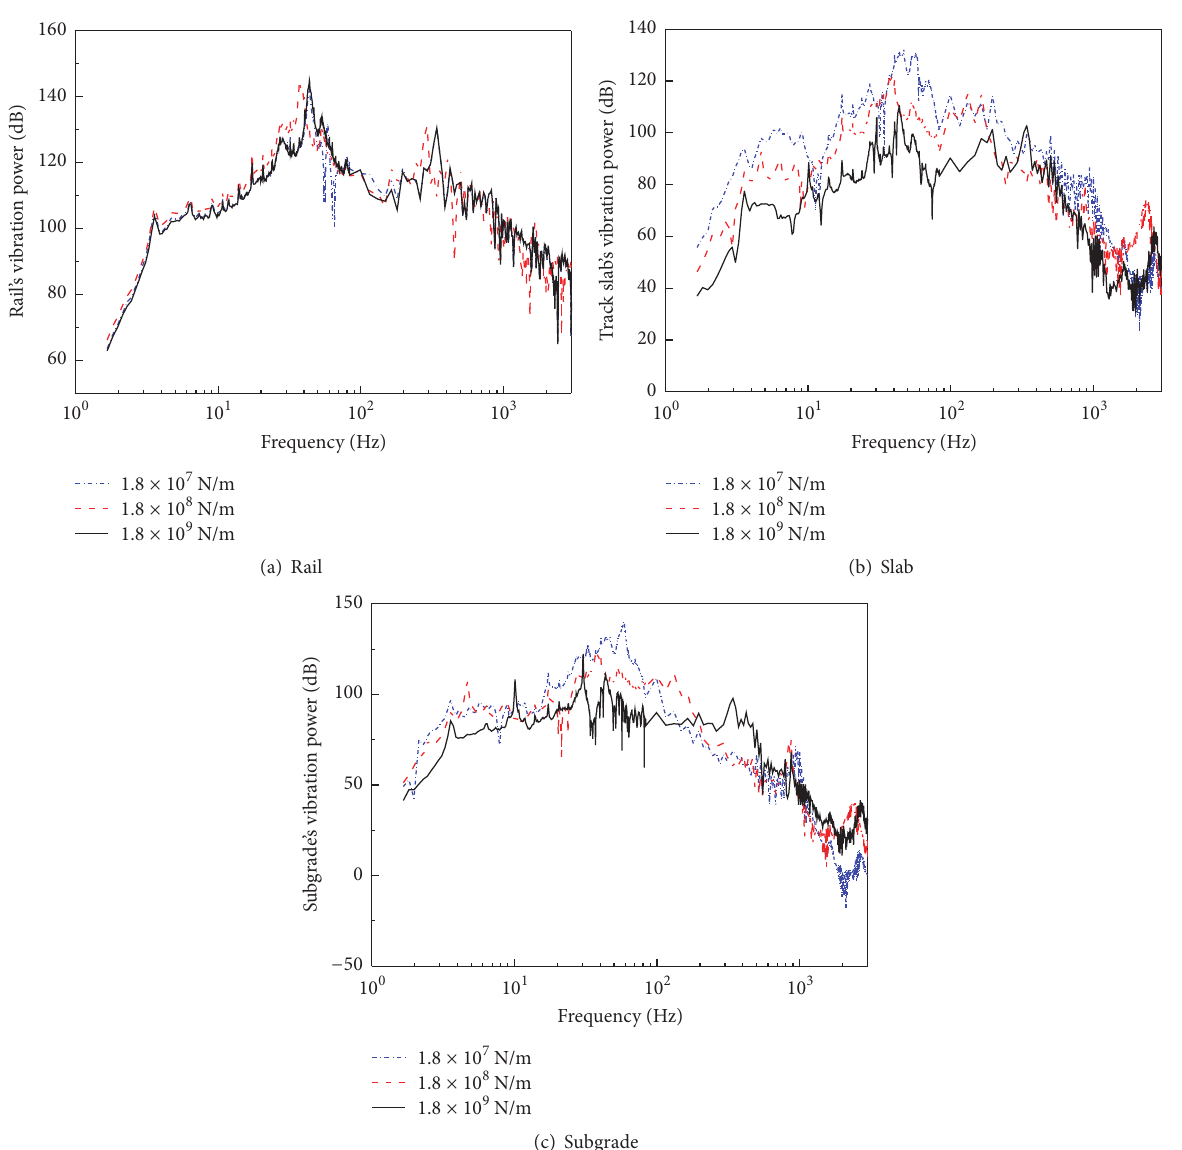
Figure 10: The effect of ACL’s stiffness on the vibration power of track and subgrade